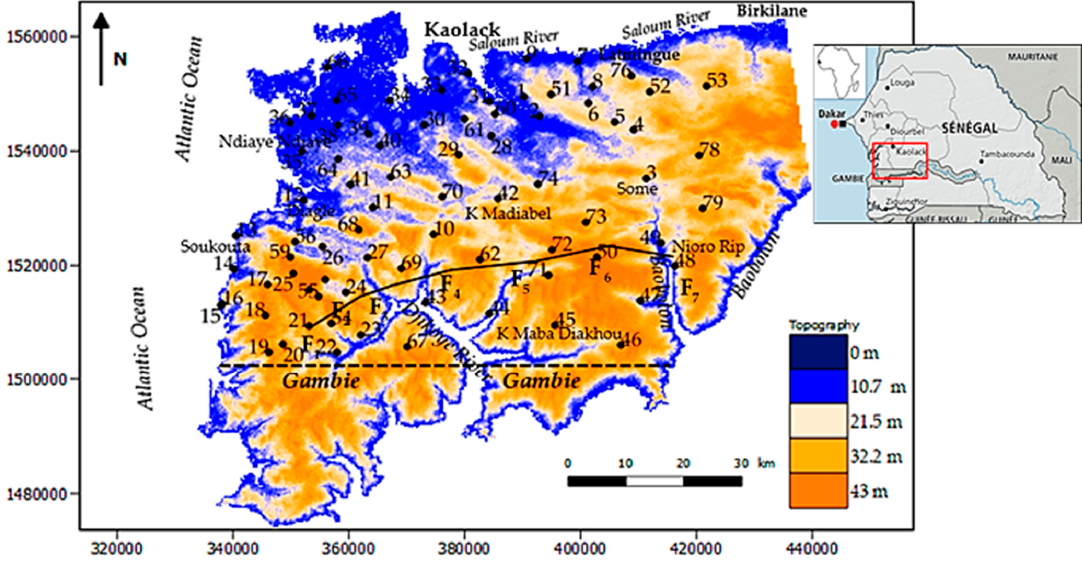
Figure 1. The location map and the sampling network.